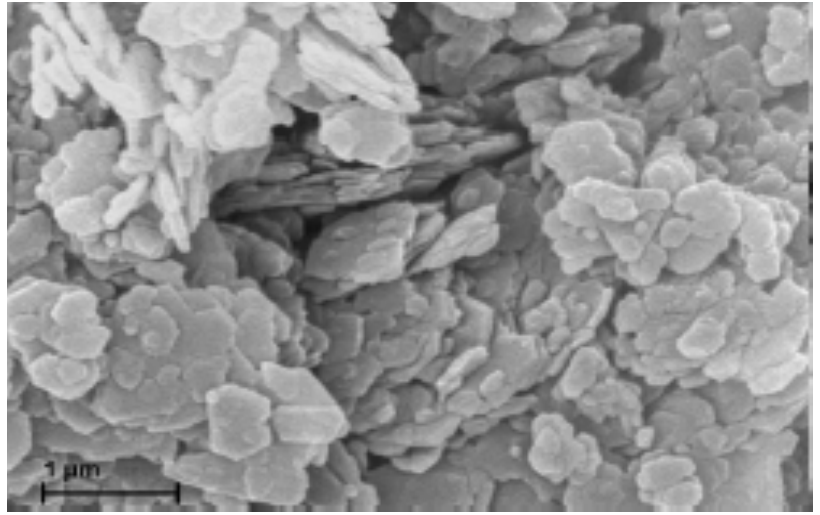
Figure 4. An SEM of MTK Particle: Reprinted from the open access source [49].